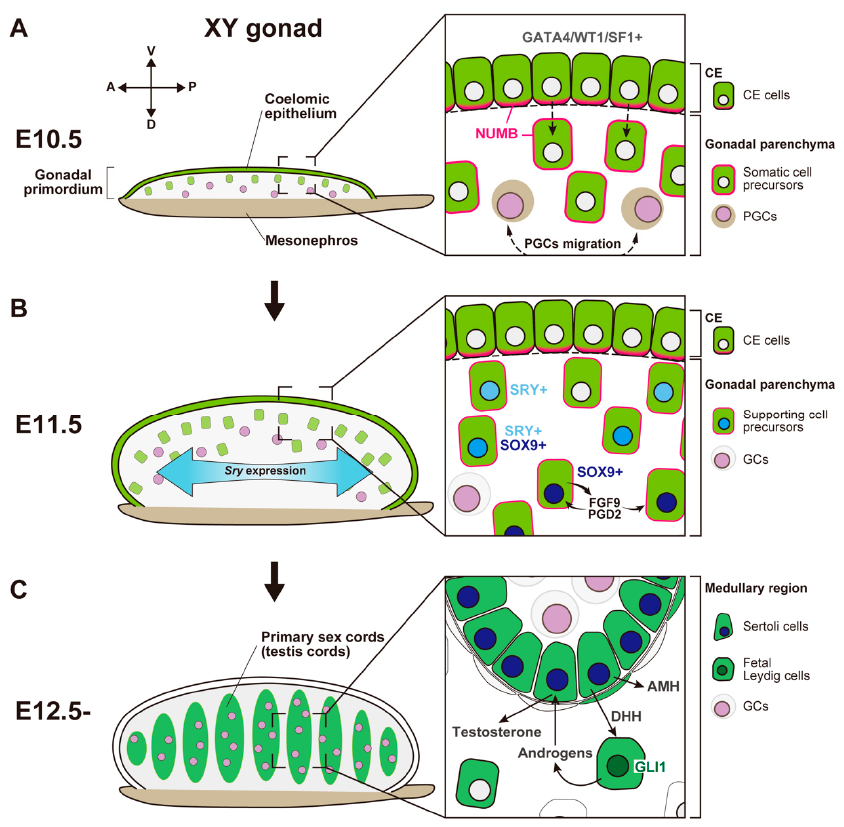
Figure 1. Schematic representation showing morphological change and somatic cell differentiation during the sex determination period, from the bipotential gonadal primordium at E10.5 to the differentiated testis at E12.5. ( A ) At E10.5, the gonadal primordium appears as a long and narrow structure composed of the coelomic epithelium (CE) and the migrated CE cells (somatic cell precursors). CE cells express GATA4/WT1/SF1, and their ingression and asymmetric cell division are primarily controlled by Notch signaling with the NUMB distribution (magenta) and Notch signaling. PGCs migration occurs around E10.5. ( B ) By E11.5, the gonadal primordium expands along the dorsoventral axis via the ingression of CE cells. Testis-specific Sry expression occurs in a center-to-pole manner along the anteroposterior axis. Beneath the CE, supporting cell precursors, SRY single- (cyan nuclei), SRY/SOX9 double- (blue nuclei), and SOX9 single- (deep-blue nuclei) positive cells, are distributed from the CE (dorsal)-to-mesonephric (ventral) side. SOX9-positive Sertoli cells secrete FGF9 and PGD2, and these factors upregulate and maintain Sox9 expression in the own and neighboring supporting cell precursors. ( C ) At E12.5, testis cords are formed by Sertoli cells and germ cells (GCs). SOX9-positive Sertoli cells secrete paracrine factors, such as AMH and DHH. DHH signaling activates its downstream factor, GLI1, in fetal Leydig cell progenitors. Fetal Leydig cells with activated GLI1 (deep-green nuclei) produce androgens, which are converted to testosterone by Sertoli cells and then induce proper differentiation of the internal and external genital